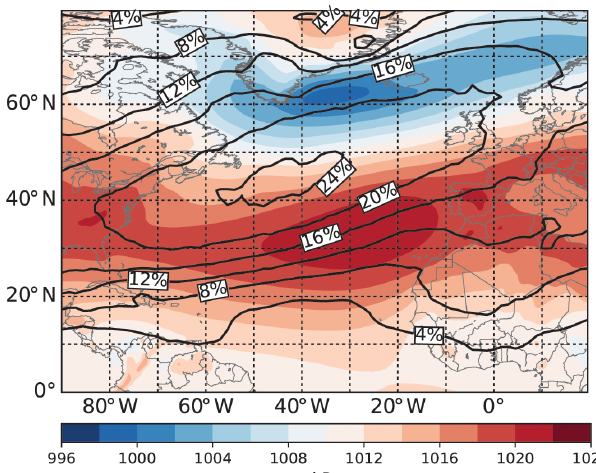
Figure 2. Climatology of daily mean sea level pressure (SLP; colour shading). Contours mark regions over which ARs are located. Num- bers indicate the relative amount of time that the respective area is covered by an ARs throughout the study period